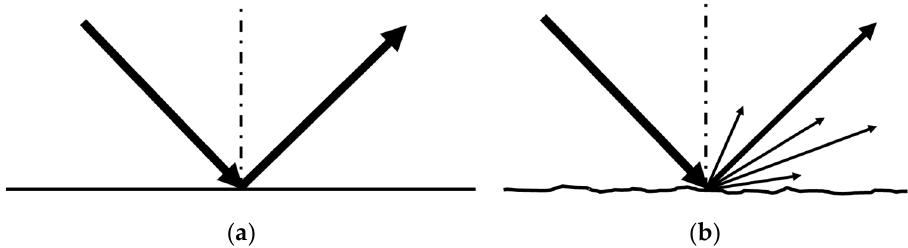
Figure 2. ( a ) Low diffuse reflectance; ( b ) high diffuse reflectance.